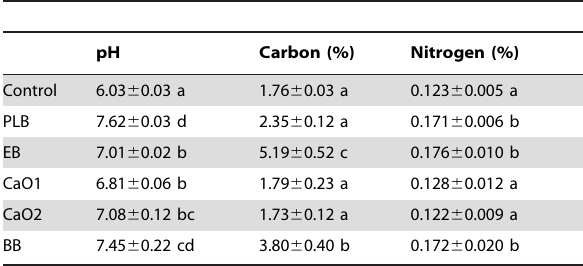
Table 2. General properties of the soils at the end of the